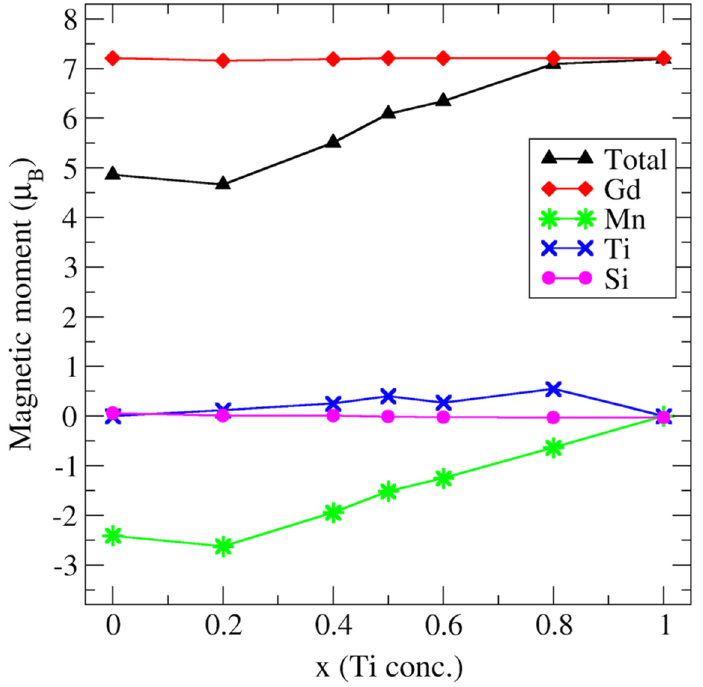
Figure 8. Total and partial magnetic moments of ions in GdMn 1- x Ti x Si depending on x (concentration of Ti), x =